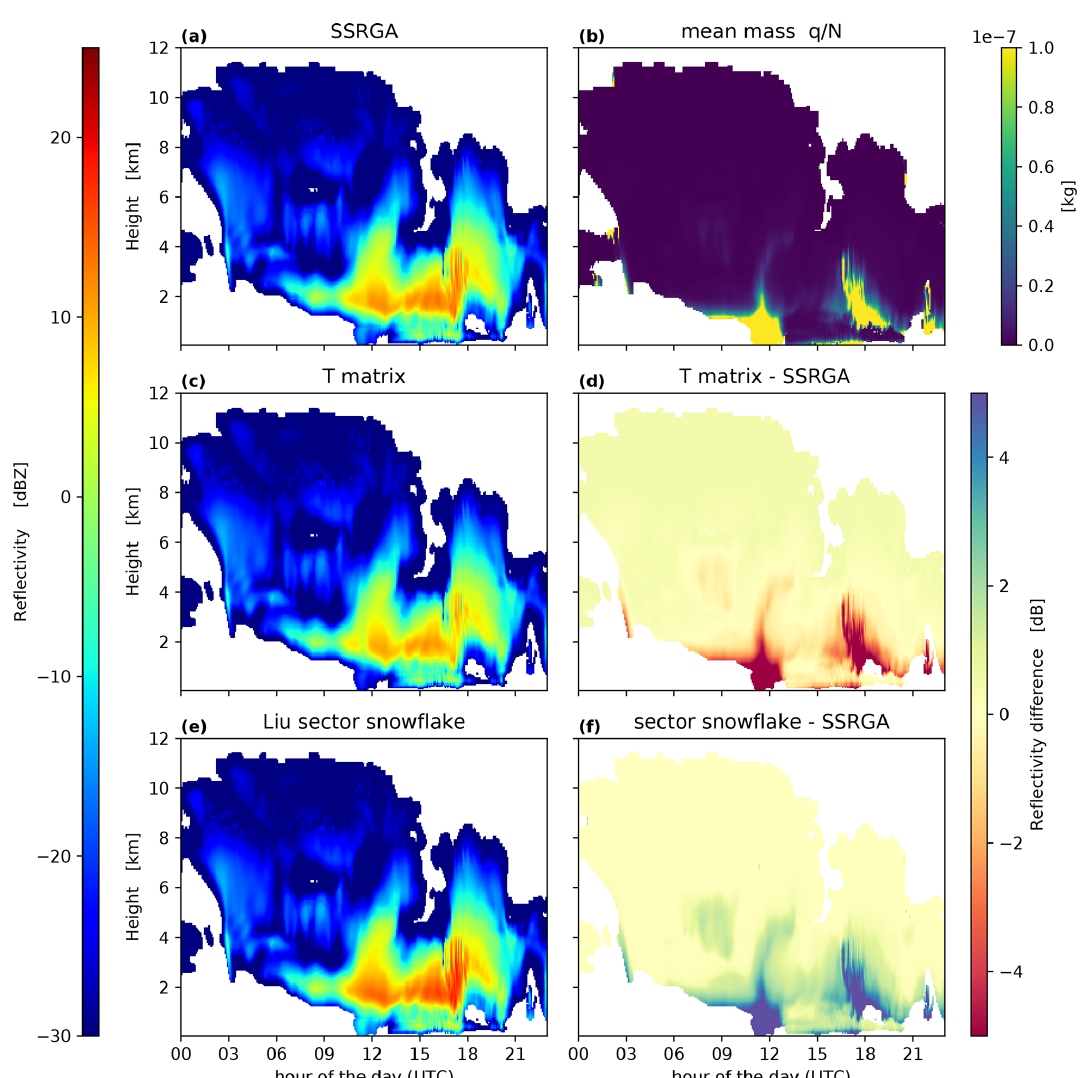
Figure 8. Simulated W-band (94GHz) radar reflectivity for the 24 November 2015 precipitation event over JOYCE based on the output of the ICON model implementing the P3 cloud microphysical scheme. Panels (a) , (c) , and (e) show the radar reflectivity forward-simulated re- spectively using the SSRGA, T-matrix, and mass-scaled DDA (Liu sector snowflake) to represent the scattering properties of snow. Panels (d) and (f) respectively show the reflectivity difference of the T-matrix and DDA solutions with the respect to the SSRGA. Panel (b) shows the mean snow mass field as predicted by the ICON